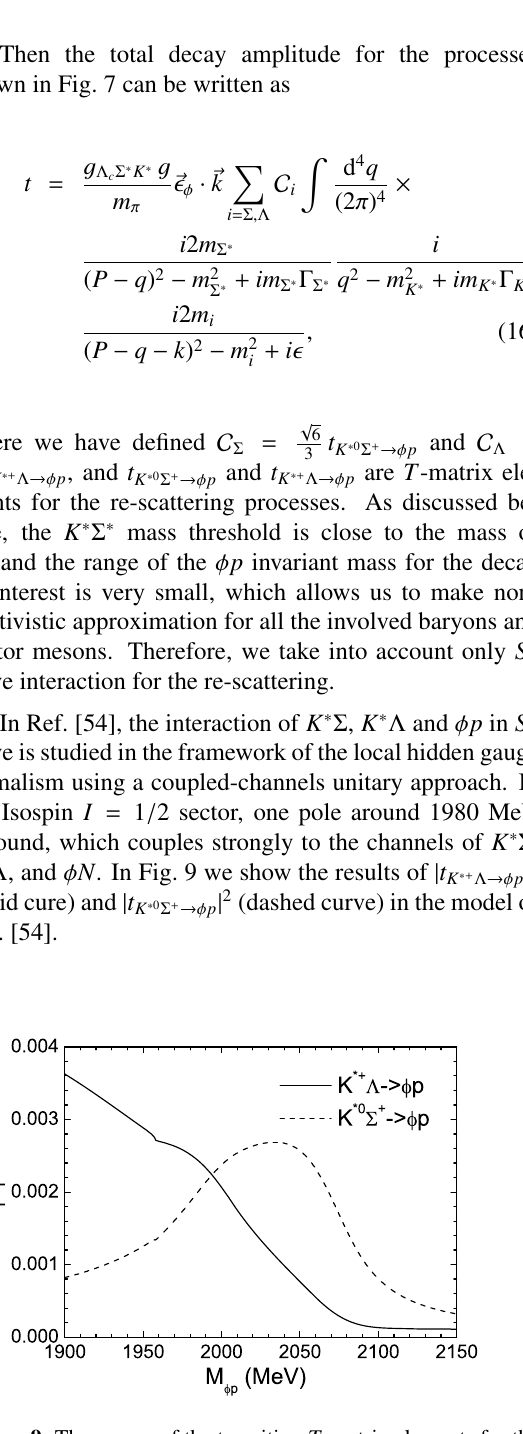
Figure 9. The square of the transition T -matrix elements for the K ∗ + Λ → φ p and K ∗ + Σ ∗ 0 → φ p as a function of the φ p invariant mass M φ p in the model of Ref.